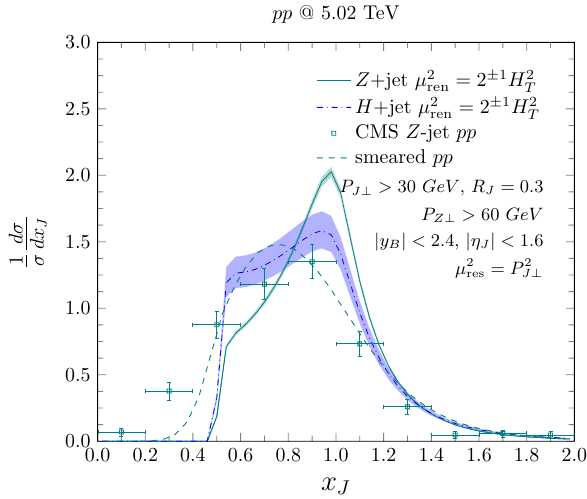
Fig. 6 Normalized momentum ratio x JZ distribution calculation for both Z +jetprocess(solid)and H +jetprocess(dashdotted)at5.02TeV. Data from the CMS [60] experiment is shown in comparison with the smeared(dashed) Z + jet result